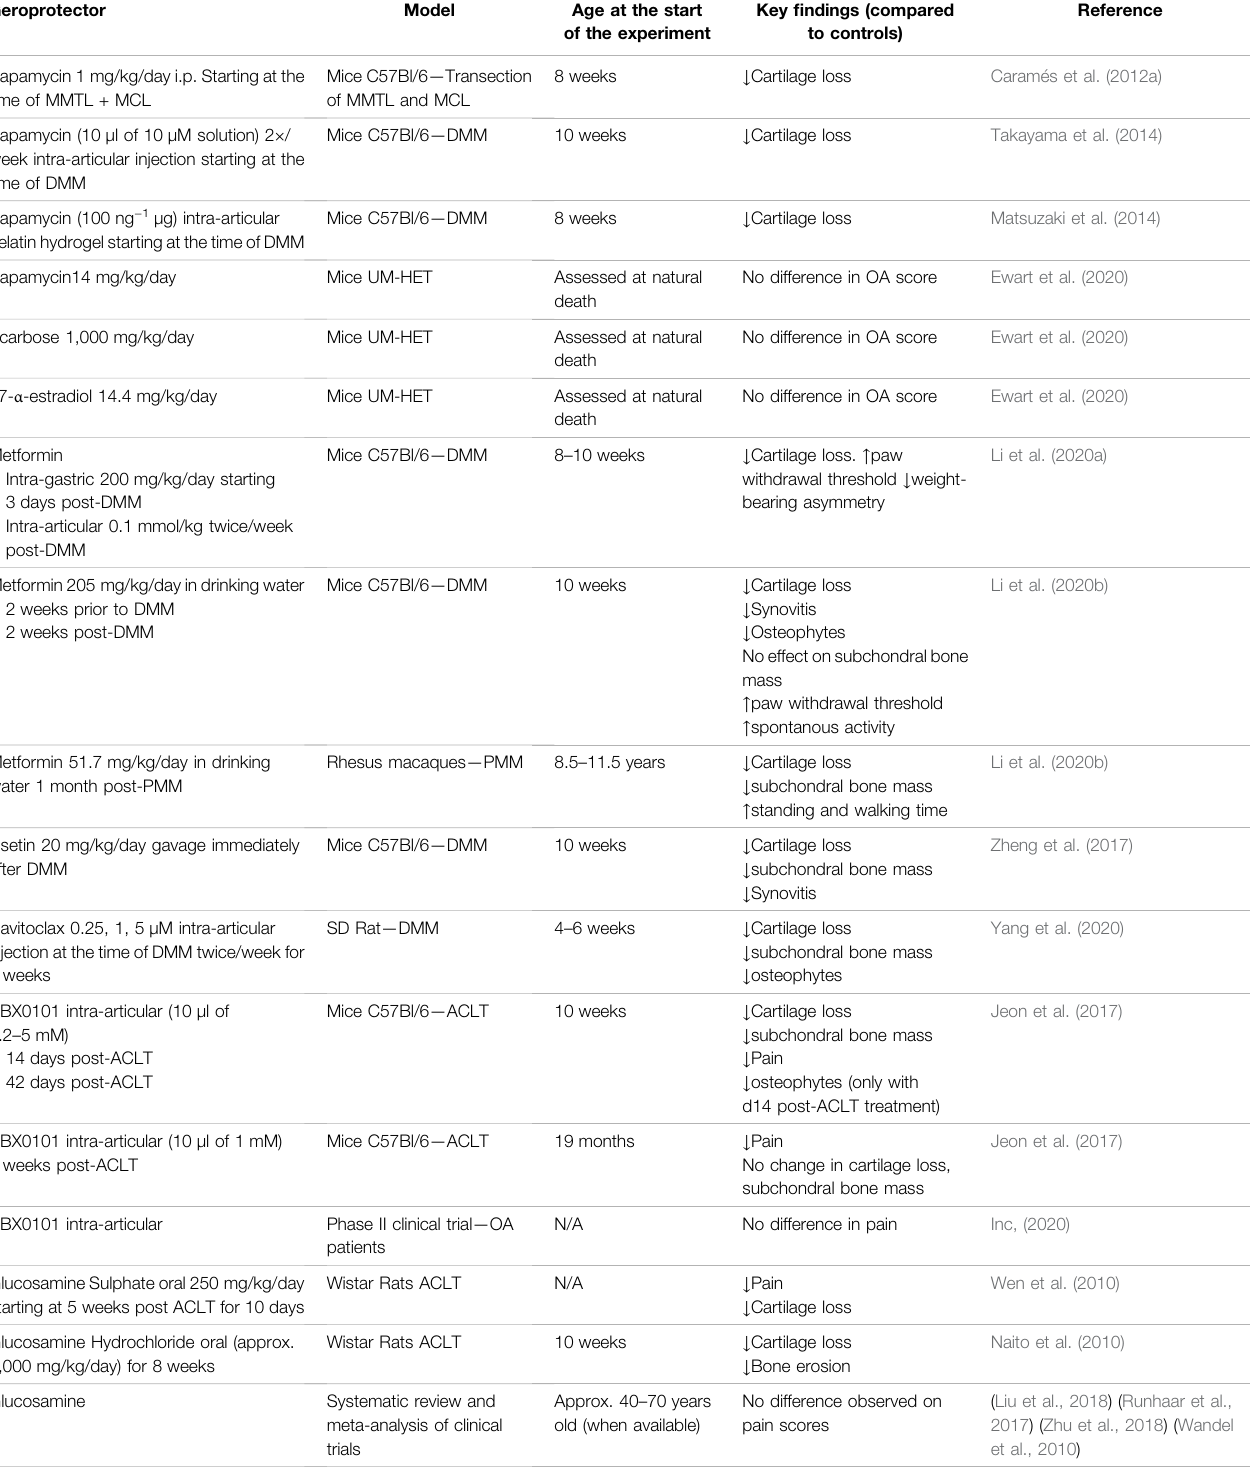
TABLE 1 | Summary of studies testing geroprotectors to attenuate OA in experimental models and patients. Geroprotector Model Age at the start